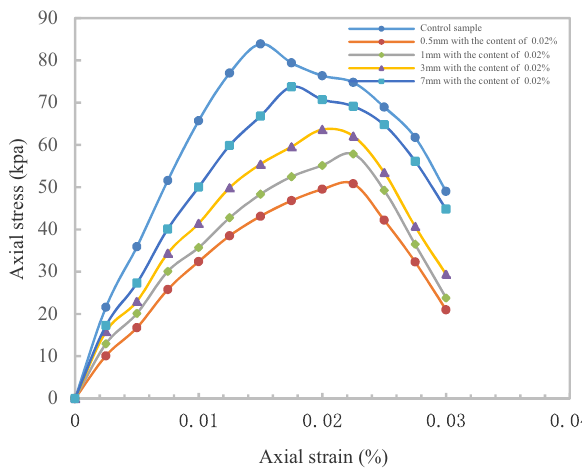
Figure 6: The stress – strain curves of di ff erent particle sizes with EPS reinforcement ratio of 0.02%.